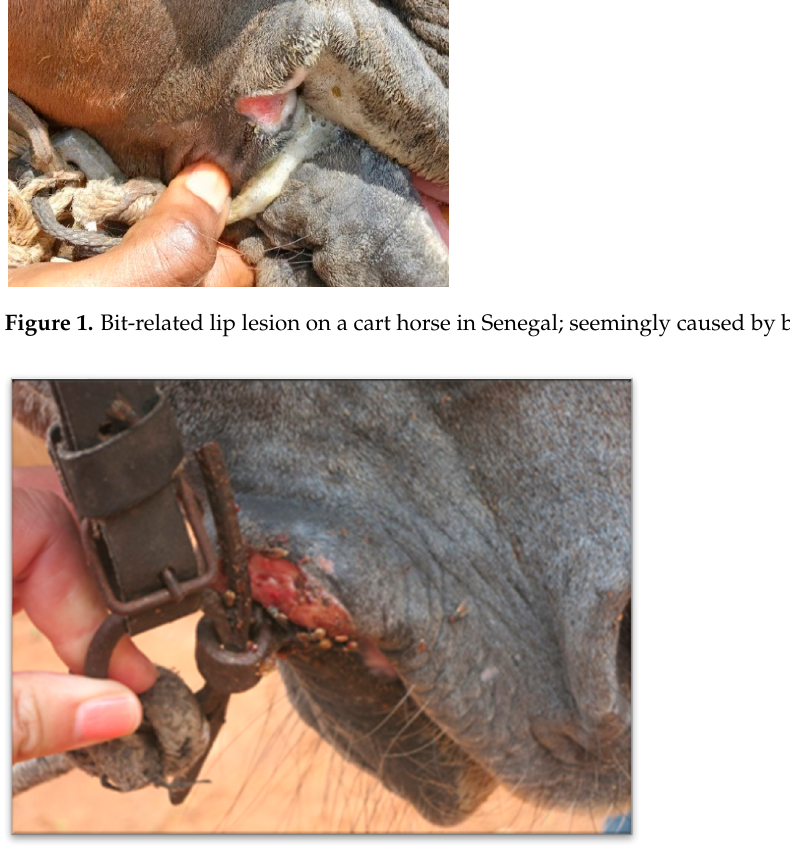
Figure 2. Bit ‐ related lip lesion on a cart horse in Senegal; seemingly caused by bit cheek ‐ piece.